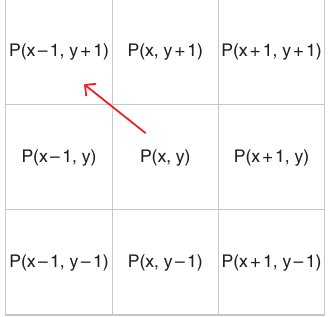
Figure 6: Pixel Value of the Image in Spatial Space.